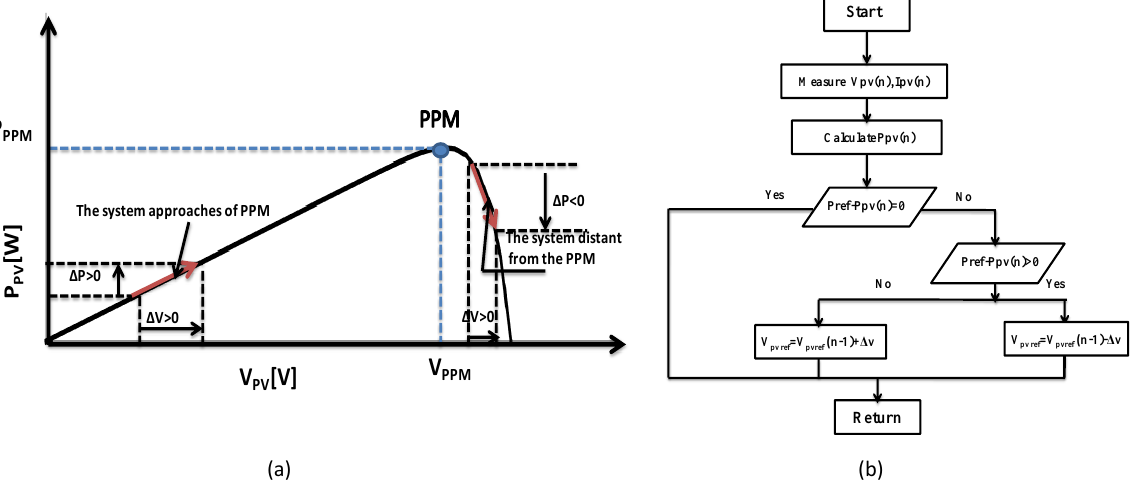
Figure 9. ( a ) Perturb and Observe-based MPPT, ( b ) Off-MPPT mode (power